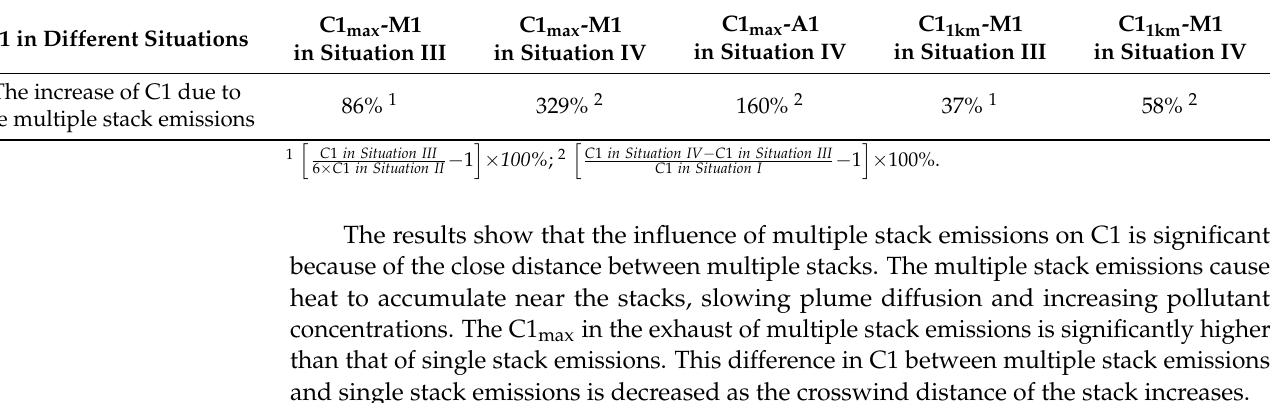
Table 4. BL2 simulations: The increase of C1 due to the multi-stack emissions in different situations. C1 max -M1 C1 in Different Situations The increase of C1 due to the multiple stack